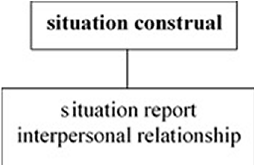
Figure 2. Japanese as a private-self-centered